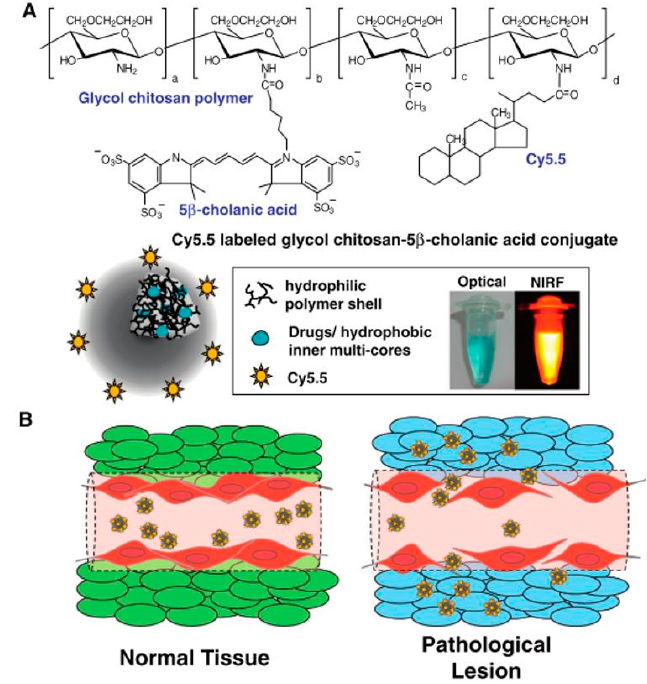
Figure 7. ( A ) Chemical structure and schematic diagram of hydrophobically-modified glycol chitosan nanoparticles for use in cancer diagnosis and therapy; ( B ) schematic diagram illustrating the accumulation of nanoparticles in pathological lesions (Adapted with permission from [41]. Copyright 2014 Elsevier B.V.).